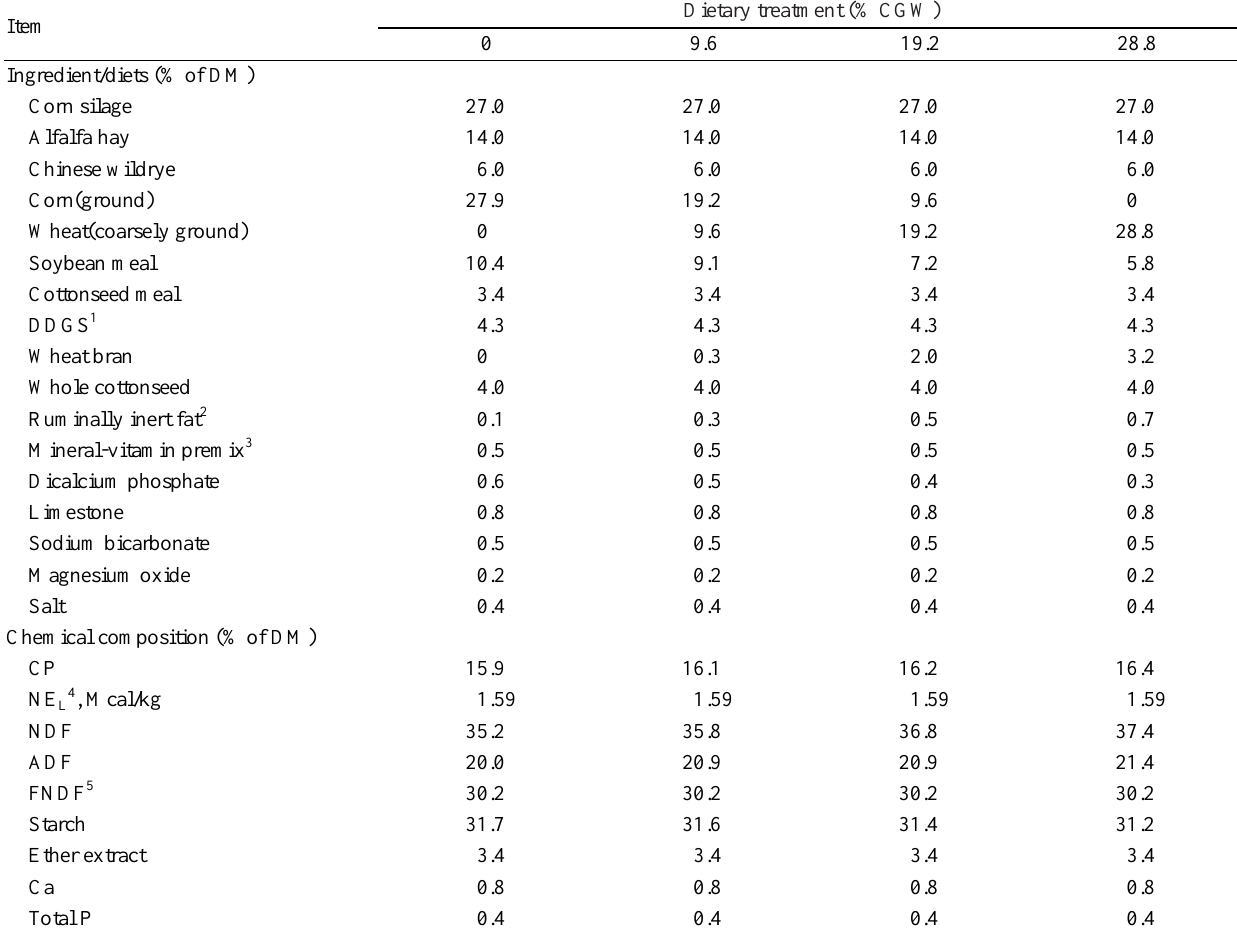
Table1. Ingredient and nutrient composition of experimental diets